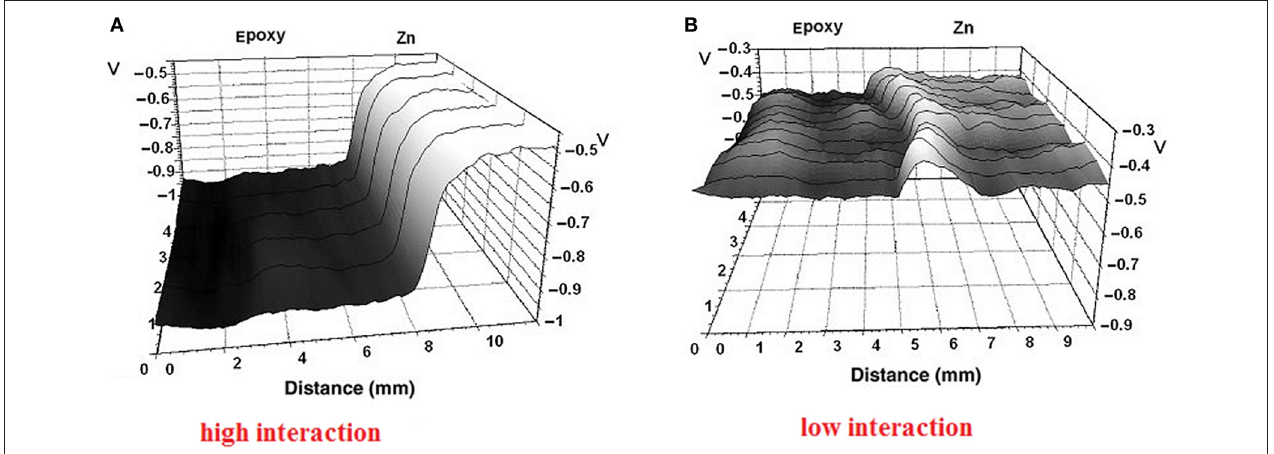
FIGURE 11 | Potential (V vs. SHE) distribution across coated and uncoated parts of zinc surface. (A) epoxy coating (EP1) with high interface interaction and (B) epoxy coating (EP2) with low interaction. Reprinted with permission from John Wiley & Sons, Ltd. Copyright 2010 (Nazarov et al.,